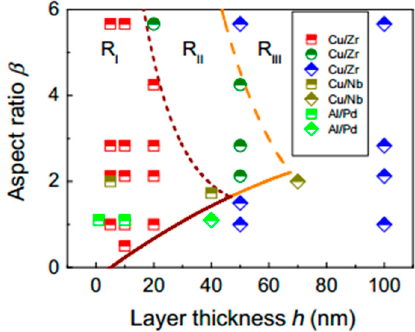
Figure 27. Deformation map for crystalline/crystalline nanolayered micropillars: shear localization in RI, shear + extrusion deformation in RII, extrusion and barreling deformation in RIII [61].